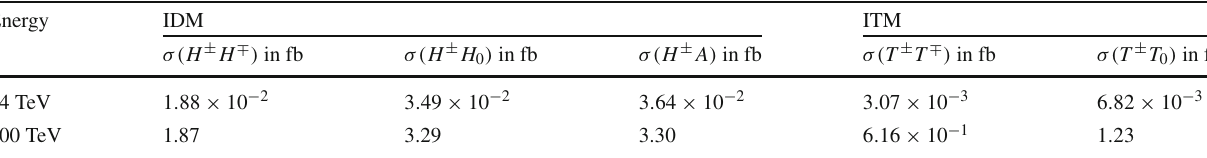
Table 3 Production cross-section at LHC for 14 TeV and 100 TeV center of mass energy for the benchmark points in Table 2